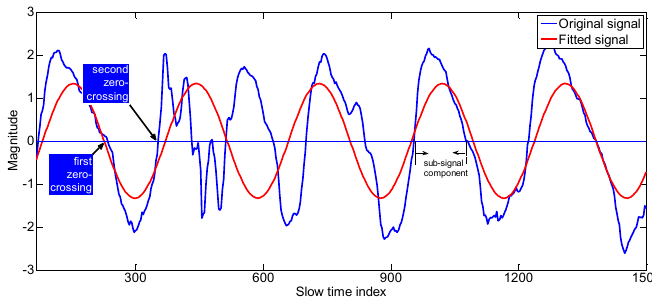
Figure 6. A best fit signal which has the corresponding r-square value of 0.46.